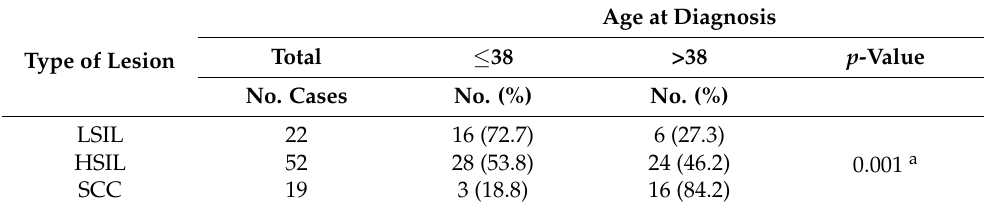
Table 1. Clinicopathological features of patients.